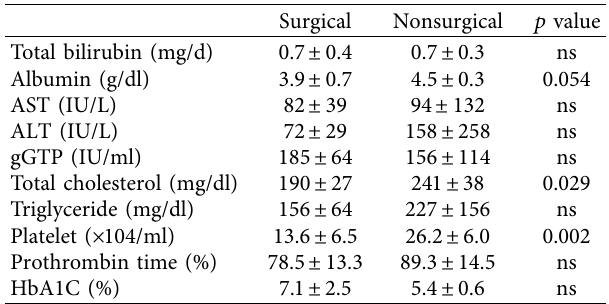
Table 3: Comparison of blood tests between surgical cases and nonsurgical cases.